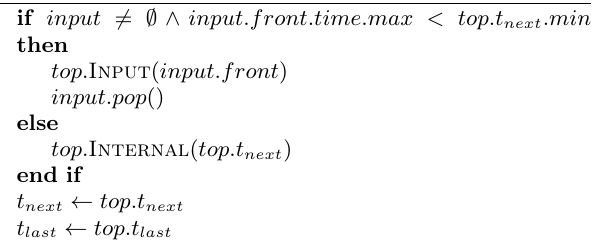
Algorithm 3 Abstract Root-Coordinator handling of non- colliding